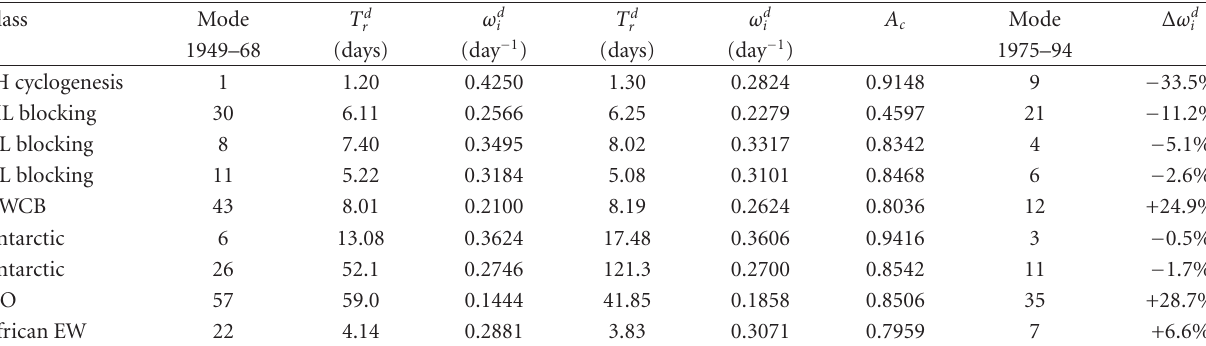
Table 2: Periods T d and growth rates ω d of selected modes for the 1949–68 NCEP/NCAR basic state with standard i r